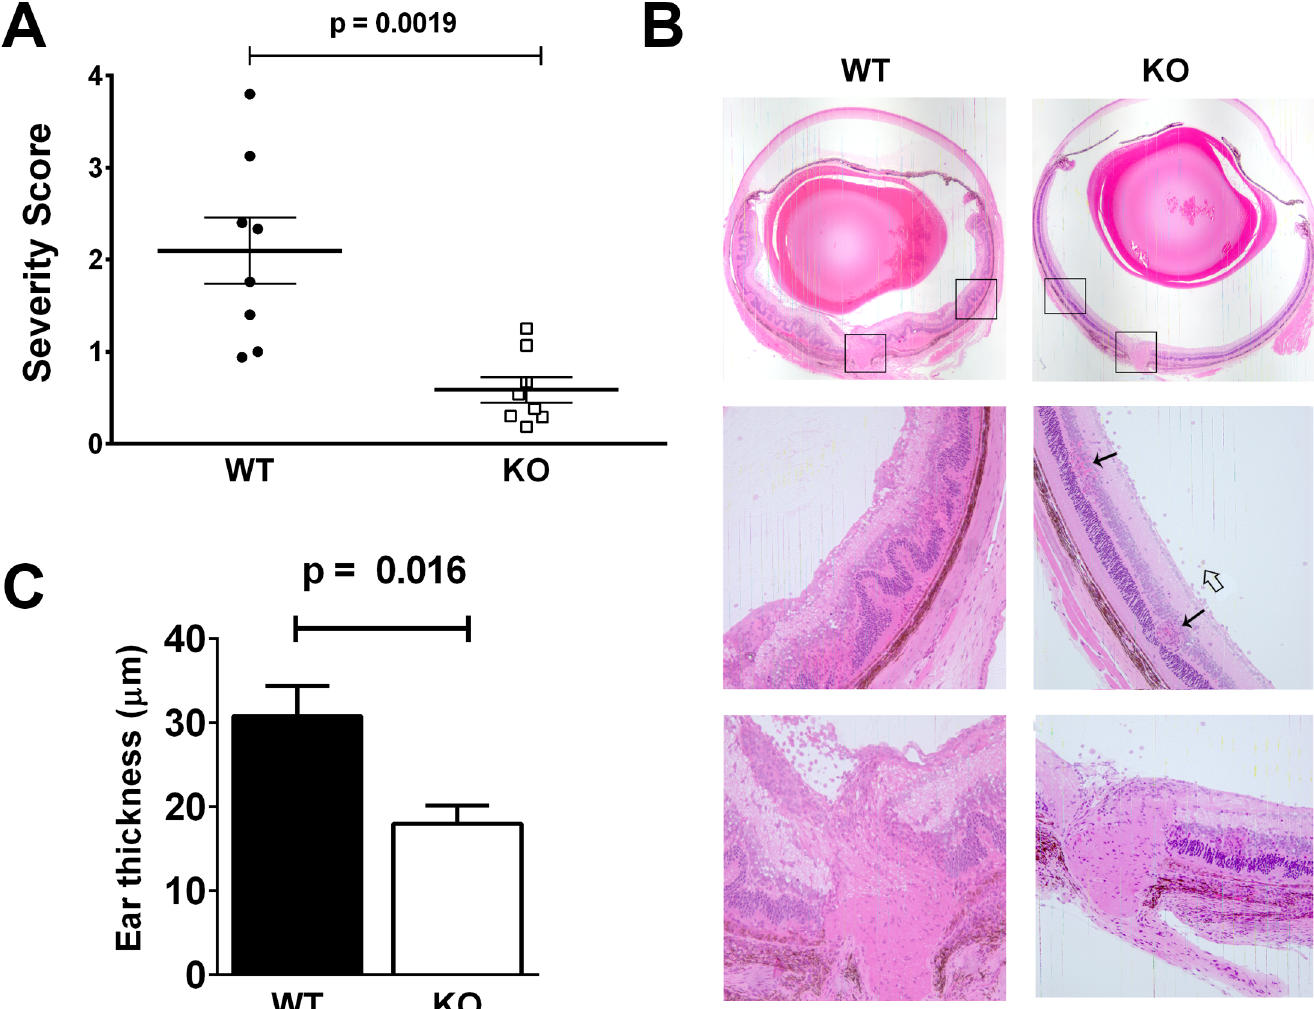
Fig 1. Lrrk2 (-/-) mice develop less severe EAU and DTH responses than their WT controls. A. A summary of disease histological scores in eye sections of Lrrk2 (-/-) ( “ KO ” ) and WT controls in eight repeated experiments, fourteen days post-immunization. Each dot represents the mean score of a mouse group in one experiment and the horizontal bars are the means ± SEM of Lrrk2 (-/-) mice and their WT controls in all eight experiments. B. Representative histological sections of eyes of a WT and an Lrrk2 (-/-) mice. Severe inflammation (scored at 3.5+) in the WT control eye, consisting mainly of intense infiltration of inflammatory cells in all retinal layers, as well as remarkable retinal folding. The eye of the Lrrk2 (-/-) mouse is affected by mild inflammation (scored at 1.0), that consists of inflammatory cells in the vitreous (an open arrow) and loci of infiltration into the retina (arrows). C . A representative DTH experiment demonstrating significantly less intense skin response in the Lrrk2 (-/-) mouse group than in their WT controls. Similar differences between the two groups were observed in two additional